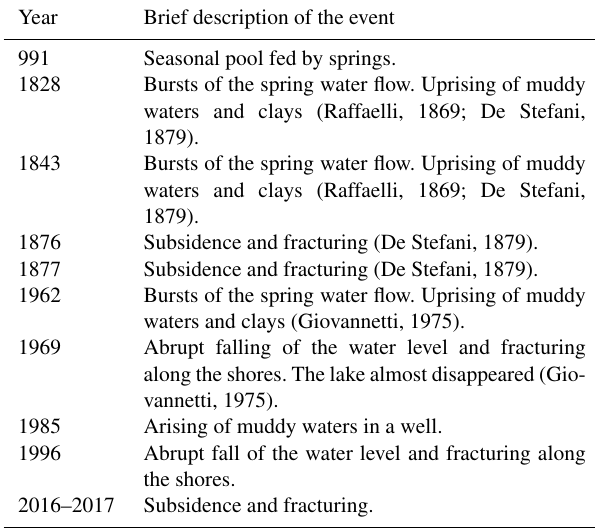
Table 1. Description of the activity at Prà di Lama